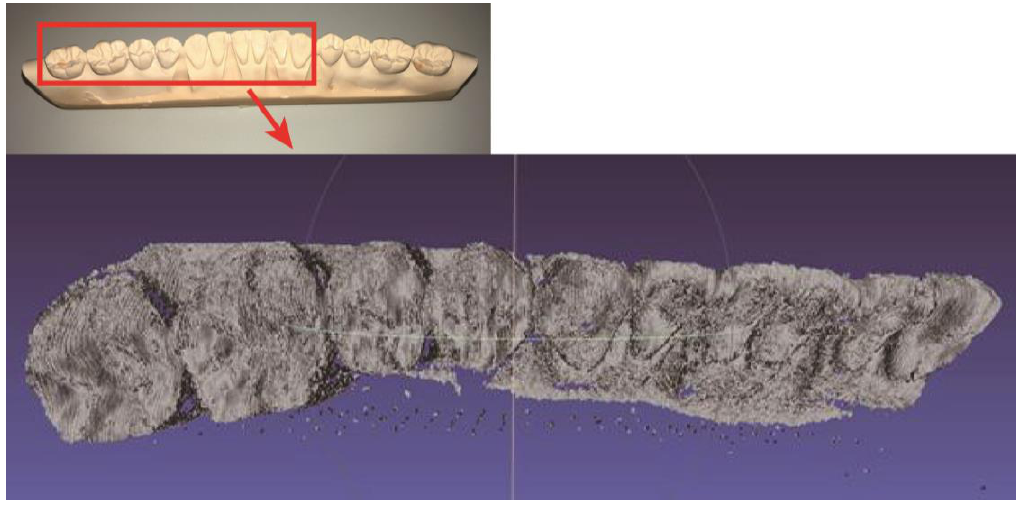
Figure 6. The 3D point cloud of the dental cast (half arch) reconstructed from 3D registration.